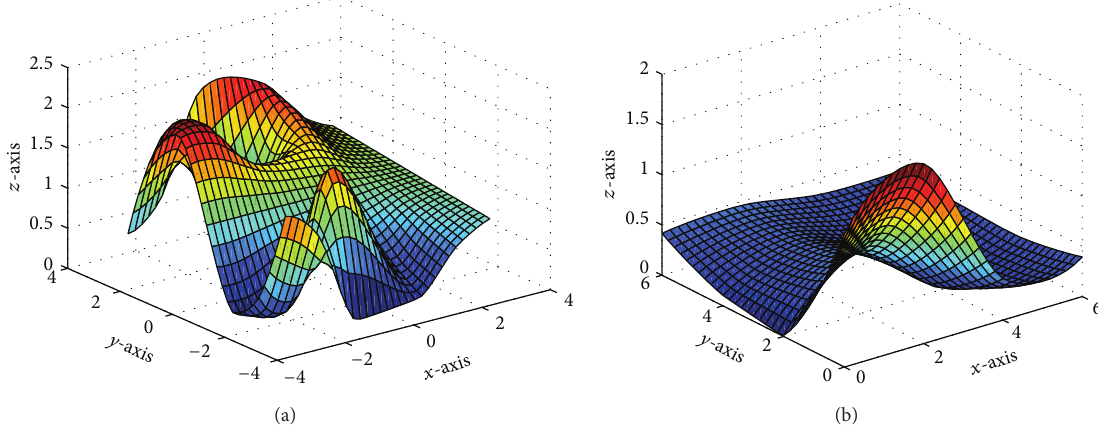
Figure 18: Positivity preserving by using the study of Abbas et al. [1] for (a) positive data in Table 3 and (b) positive data in Table 4.